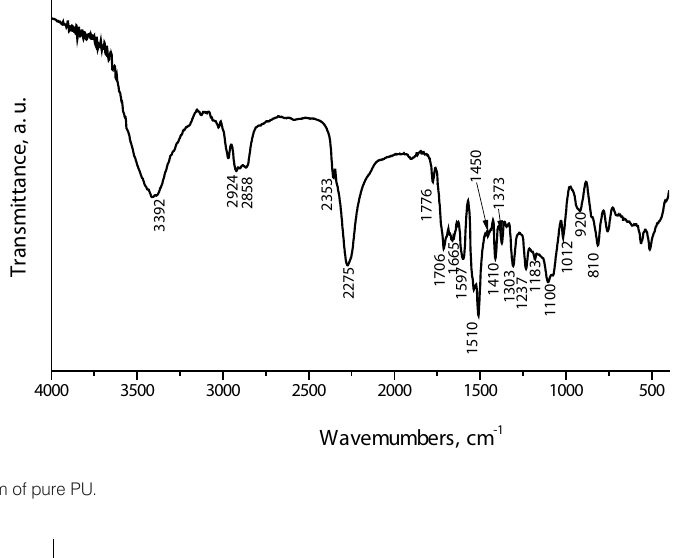
Figure 2. FTIR spectrum of pure PU.